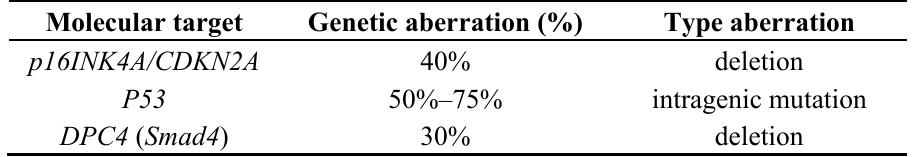
Table 2. Tumor suppressors in PDAC: genetic aberration percentage and